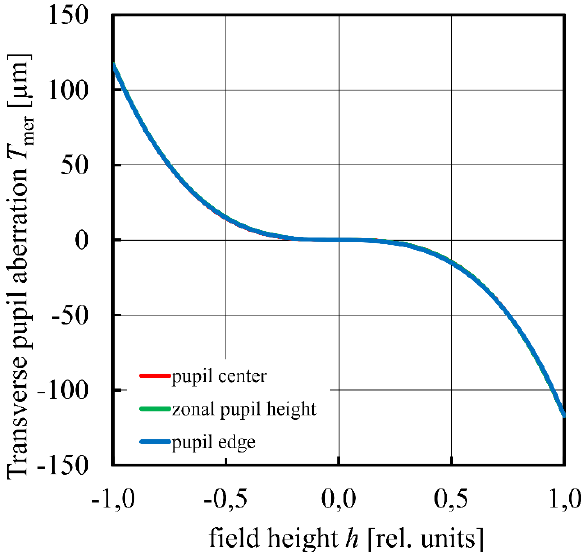
Fig. 4. Transverse pupil aberration T mer in meridional direction for three resulting pupil heights, that refer to ray angles in object space, namely 0° (pupil center, red), 8,16° (zonal, green) and 11,54° (pupil edge,